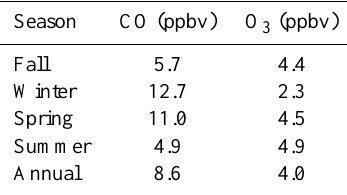
Table 3. Contribution to CO and O 3 at PMO from North American fossil fuel emissions simulated by the GEOS-Chem model (means for every season from fall 2000 to summer 2010).